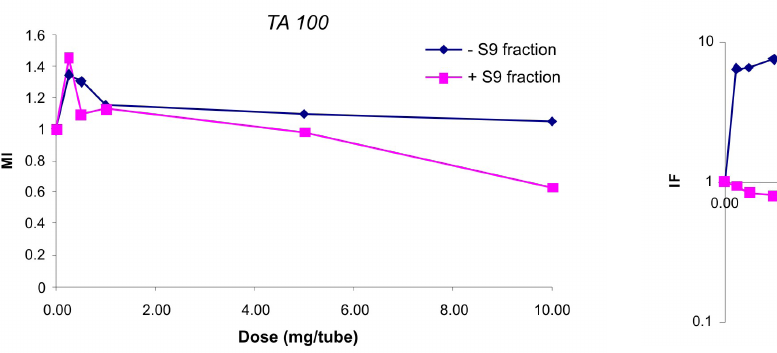
FIGURE 6 - Induction Factor (IF) as a function of dose (mg/ tube) of “barbatimão” extract (BE), with or without S9 fraction, on E. coli WP2s( l ). The maximum coefficient of variation (CV) of experiments was 10%. Plots represent average of four independent